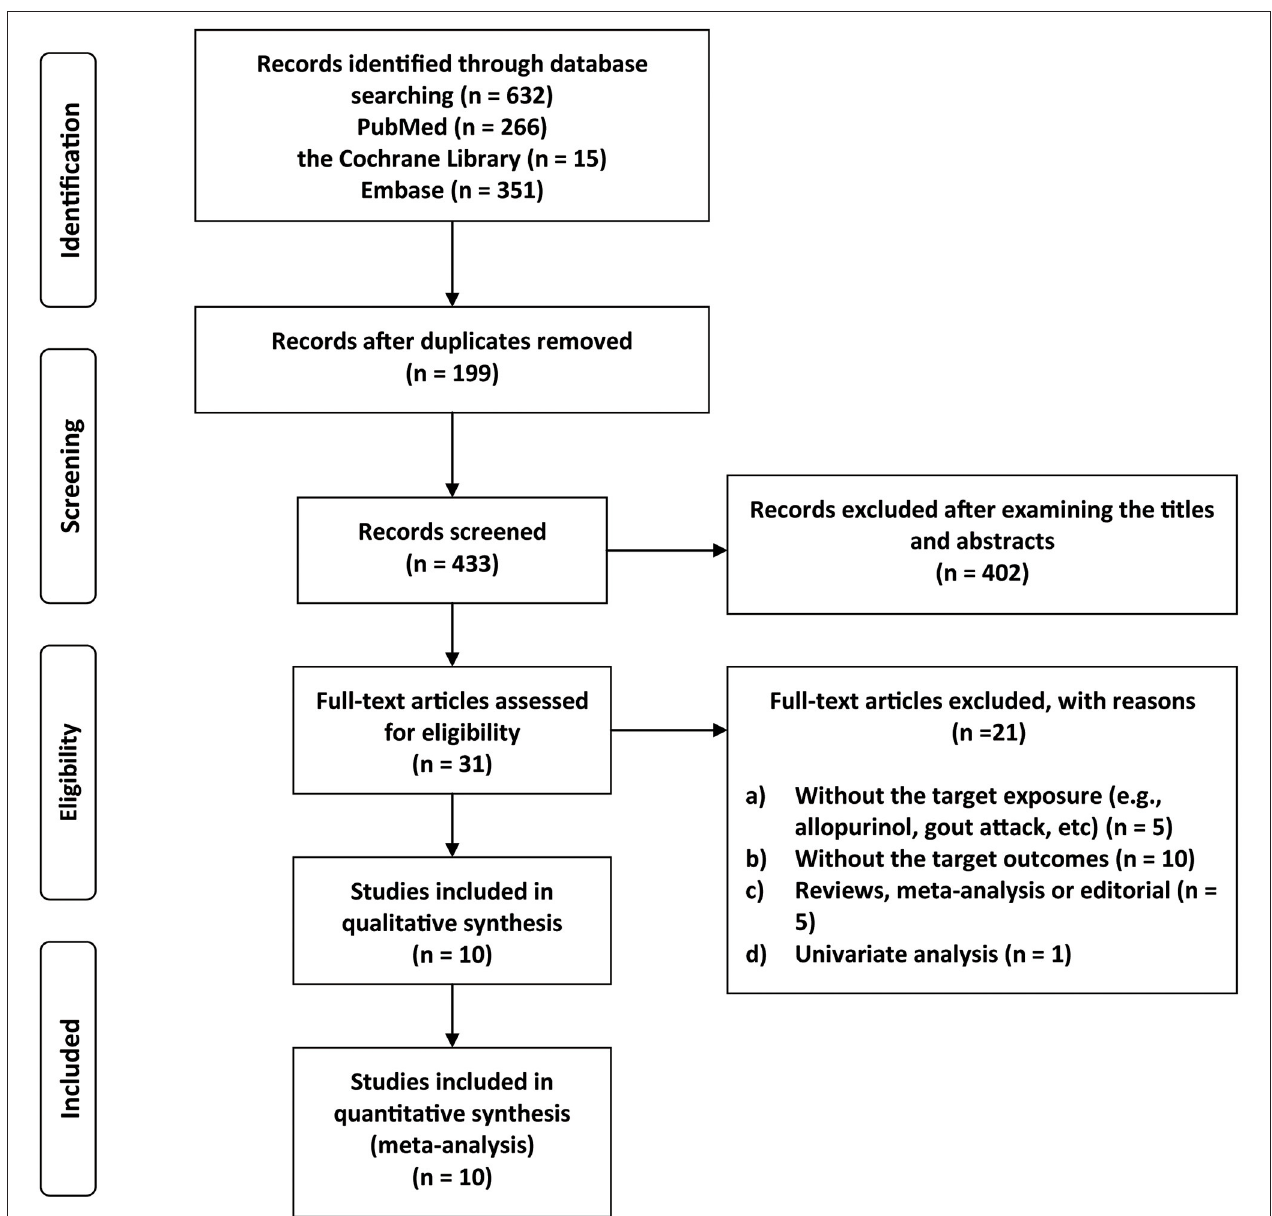
FIGURE 1 | Flow chart of study selection.